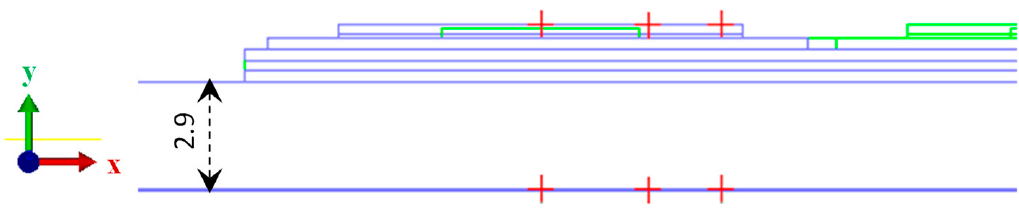
Figure A2. Power module on a cold plate from the simulation study in Section 3, excerpt from Figure A1. Temperature monitor points are marked as “ + ”.